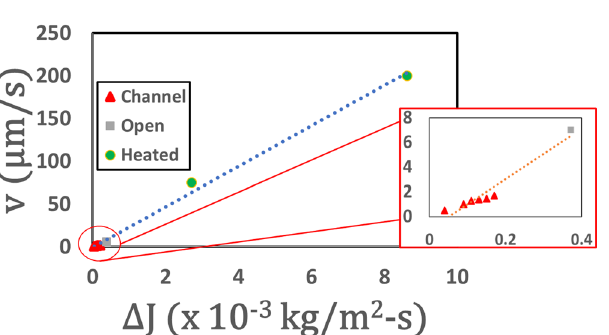
Figure 3. Velocity as a function of spatial variation in evaporation rate. Inset shows the magnified view of the channel data. Heated data is taken from [ref. 15]. For open and heated cases, J variation is determined using the ∂ c ( ) J D cos sin c 18 where D: diffusion coefficient, c: vapor concentration and α : as shown equation α α = − + ∂ ∂ ∂ r z in the Fig. 1b. For confined droplet, J ′ variation is in the azimuthal direction, i.e., ∆ = ′ −